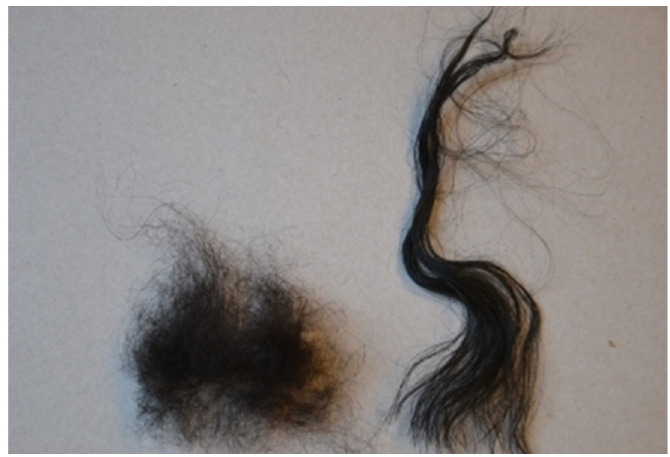
Figure 2. Wool and guarded hair forming the fleece of mountain sheep .